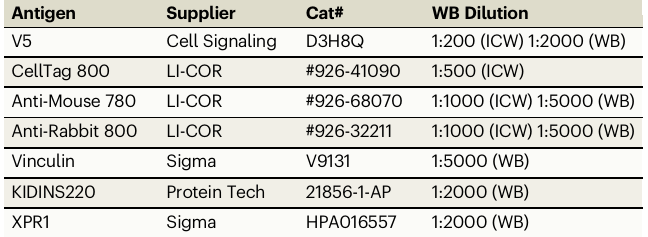
Table 2 contains the dilutions and catalog numbers of all antibodies used in this study.